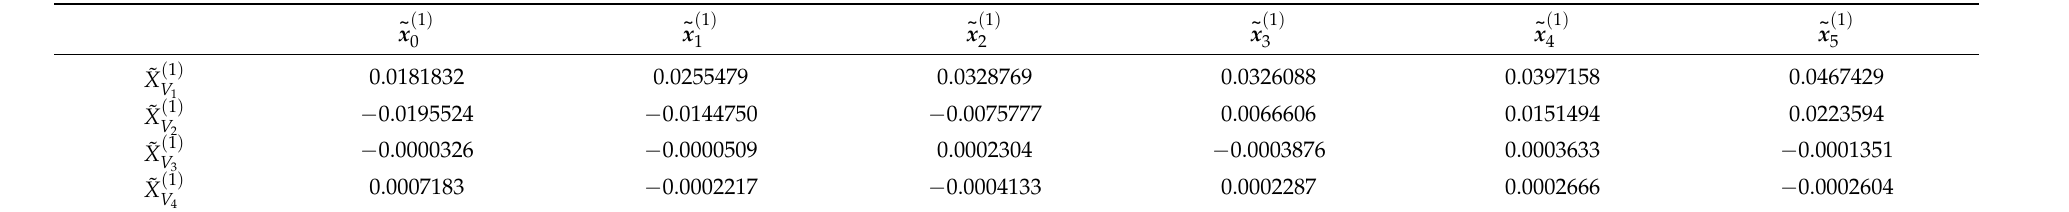
Table 7. Reconstruction stage of principal components of marker M 1